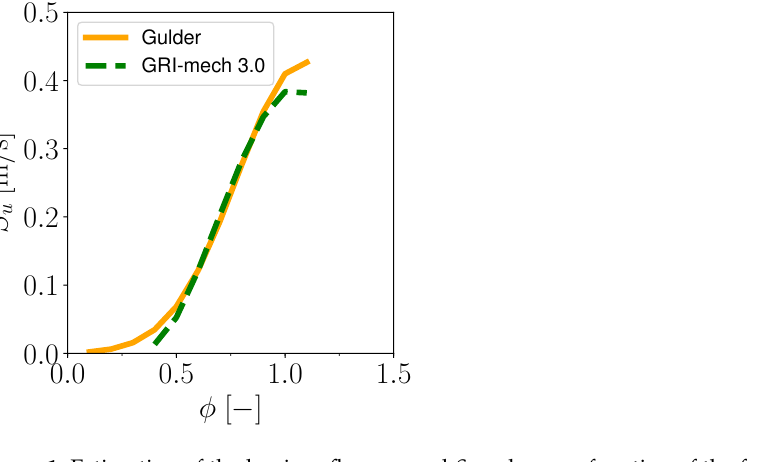
Figure 1. Estimation of the laminar flame speed S u value as a function of the fresh CH 4 -air mixture equivalence ratio φ at ambient conditions ( p = 1.01325 bar; T = 300 K): comparison between Gulder’s correlation and a tabulation approach with the GRI-mech 3.0 mechanism.